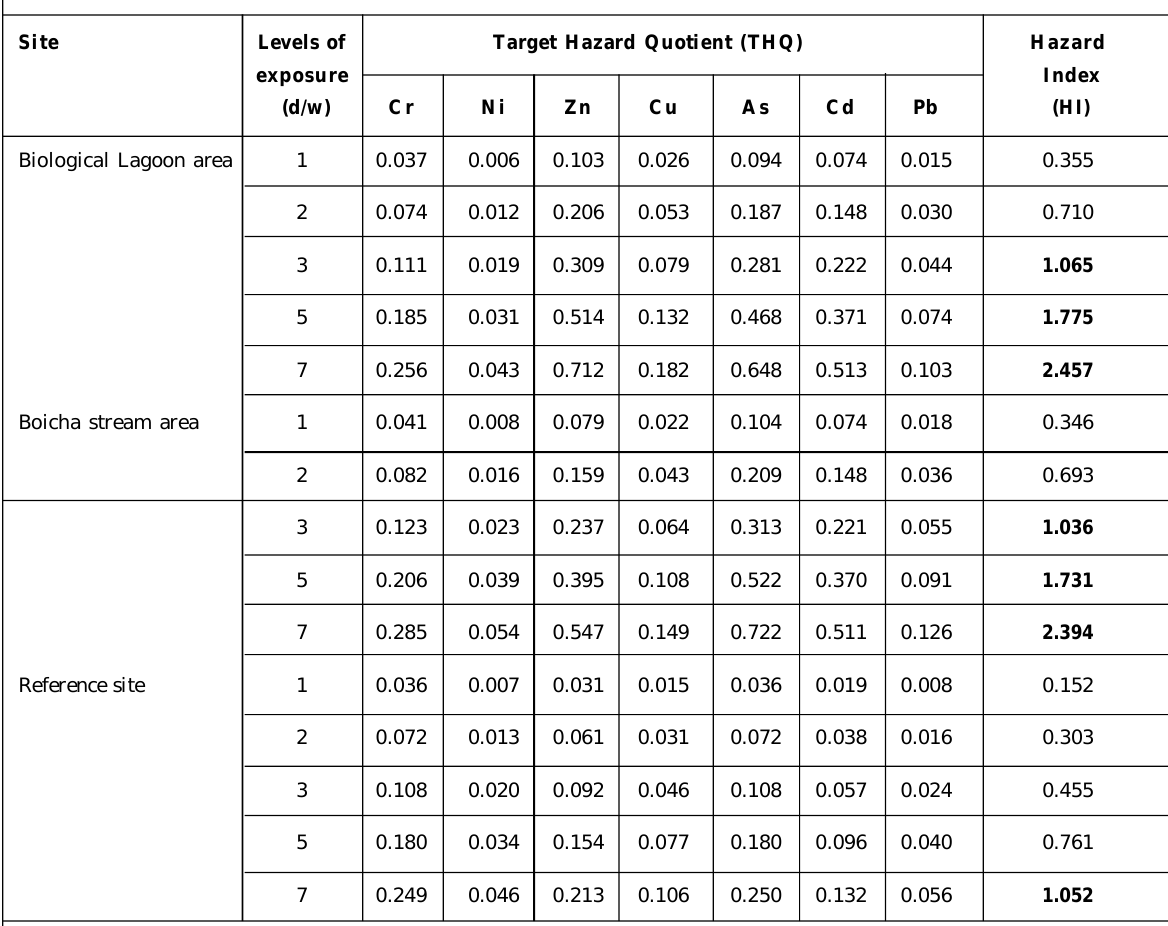
Table 2: Target Hazard Quotient (THQ) and Hazard Index (HI) of heavy metals from consumption of cabbages from the study sites at different levels (days per week) of exposure Site Levels of Target Hazard Quotient (THQ)